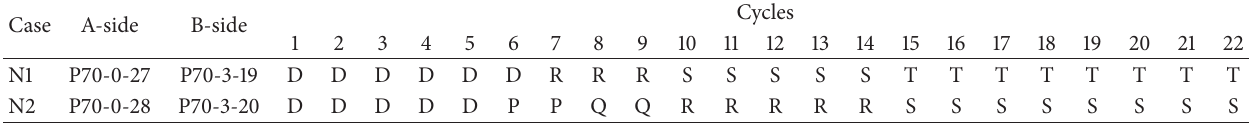
Table 1: Case design for the effect of nitrite